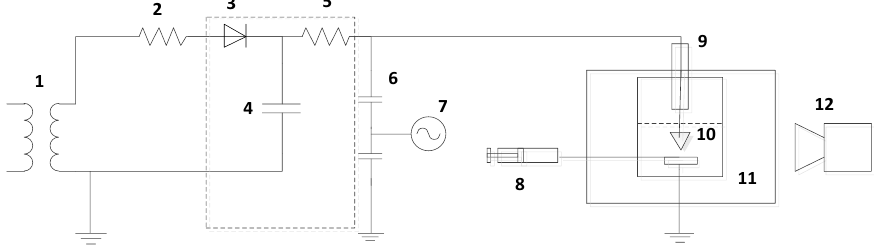
Figure 1. The schematic diagram of the experimental system .